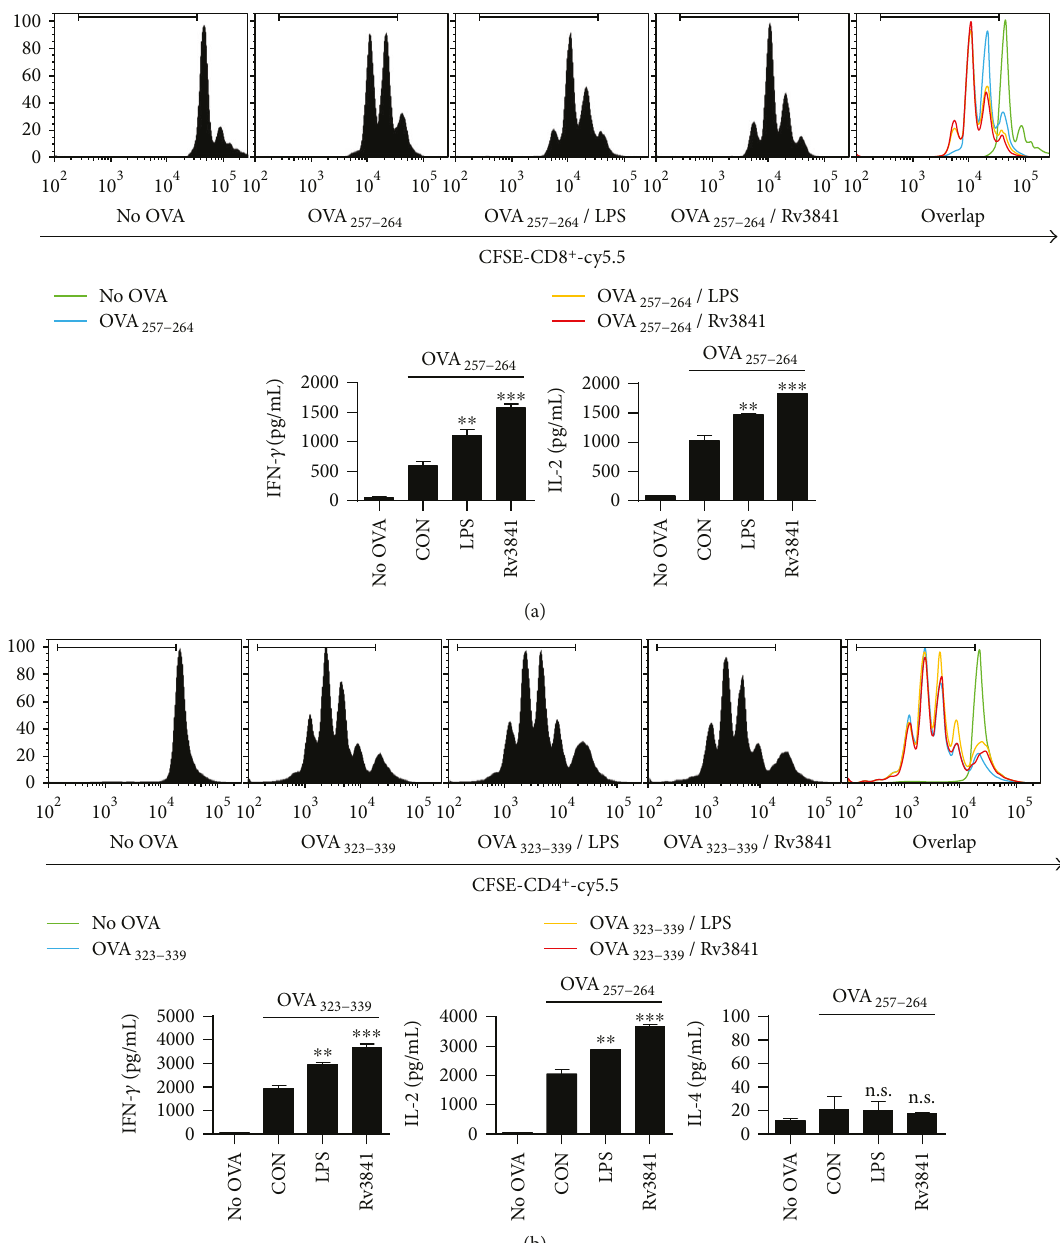
Figure 4: Rv3841-treated DCs stimulate T-cells to produce Th1 cytokines. (a, b) Transgenic OVA-speci fi c CD4 + T-cells were isolated using MACS from OT-I and OT-II mouse splenocytes, were stained with CFSE, and were cocultured for 96 h with DCs that had been treated with Rv3841 (10 μ g/mL) or LPS (100ng/mL) and then pulsed with OVA (1 μ g/mL) or OVA (1 μ g/mL) to produce OVA-speci fi c 257 – 264 323 – 339 CD4 + T-cells. (a) The proliferation of OT-I T-cells was then assessed by fl ow cytometry. T-cells alone or T-cells cocultured with untreated DCs served as the controls. Representative histograms from three independent experiments are shown. Culture supernatants were harvested after 96h, and the IFN- γ , IL-2, and IL-4 concentrations were determined by ELISAs. The mean values ± SD ( n = 3 ) are shown; ∗∗ p < 0 01 or ∗∗∗ p < 0 001 : a signi fi cant di ff erence of treatment groups from the appropriate controls (T-cells + OVA -pulsed DCs or 257 – 264 T-cells+ OVA -pulsed DCs), as determined by one-way ANOVA. Treatments without a signi fi cant e ff ect are indicated by “ n.s. 323 – 339